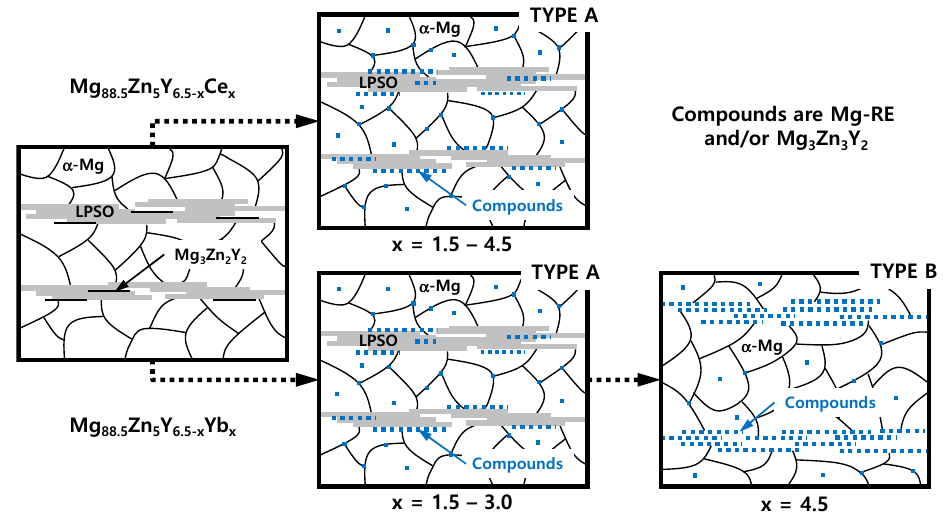
Figure 13. Schematic diagram of the microstructures of the Mg-Zn-Y-RE alloys.